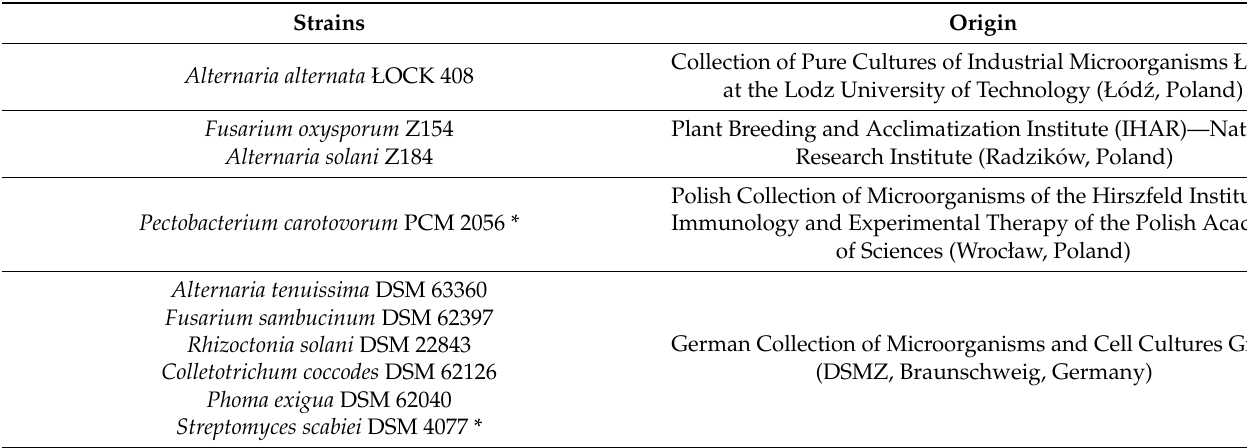
Table 5. Potato pathogens used in the